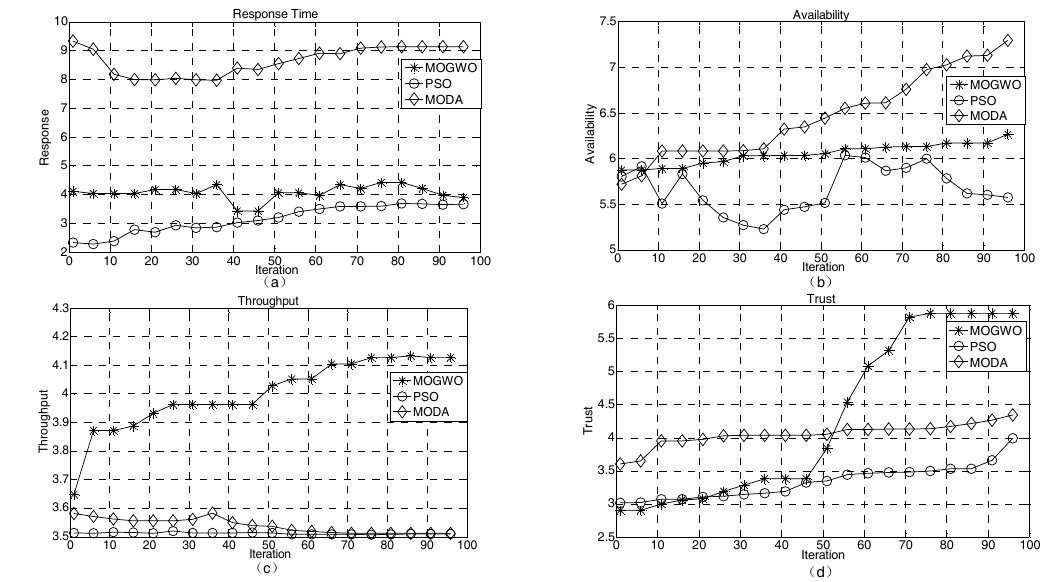
Figure 8. Algorithm mean comparison. ( a ) response time; ( b ) availability; ( c ) throughout; ( d ) trust. MOGWA—multi-objective gray-wolf optimizer; PSO—particle swarm optimization; MODA—multi- objective dragonfly algorithm.